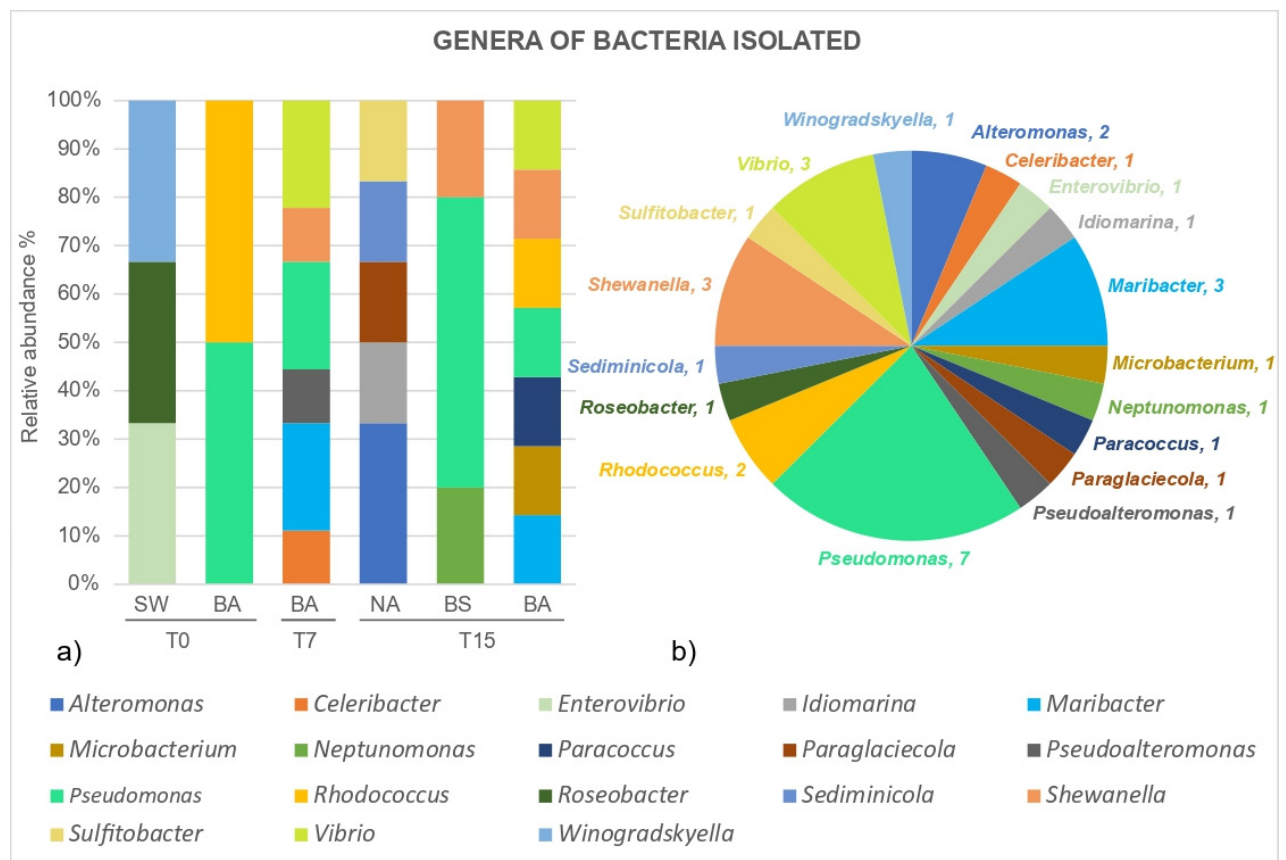
Figure 6. Genera of the bacterial strains obtained in the microcosm bioremediation experiment. ( a ) Relative abundance of the obtained bacterial genera in the natural seawater (SW), in the bioaugmentation (BA) treatment at the beginning (T0), after 7 days of experiment (T7) and at the end of the experiment (after 15 days) (T15), and in the natural attenuation (NA) and biostimulation (BS) treatment after 15 days (T15). ( b ) Total number of bacteria genera obtained in all treatments of the microcosm bioremediation experiment.